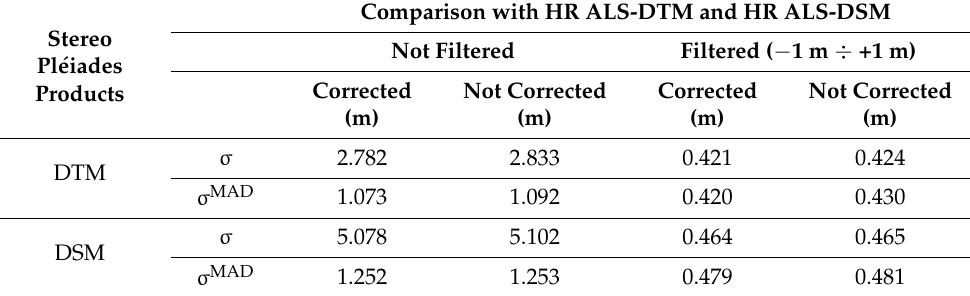
Table 6. Standard deviation and the median absolute deviation obtained for the Pl é iades DTM and DSM point clouds in comparison with the HR ALS-DTM and HR ALS-DSM, respectively.